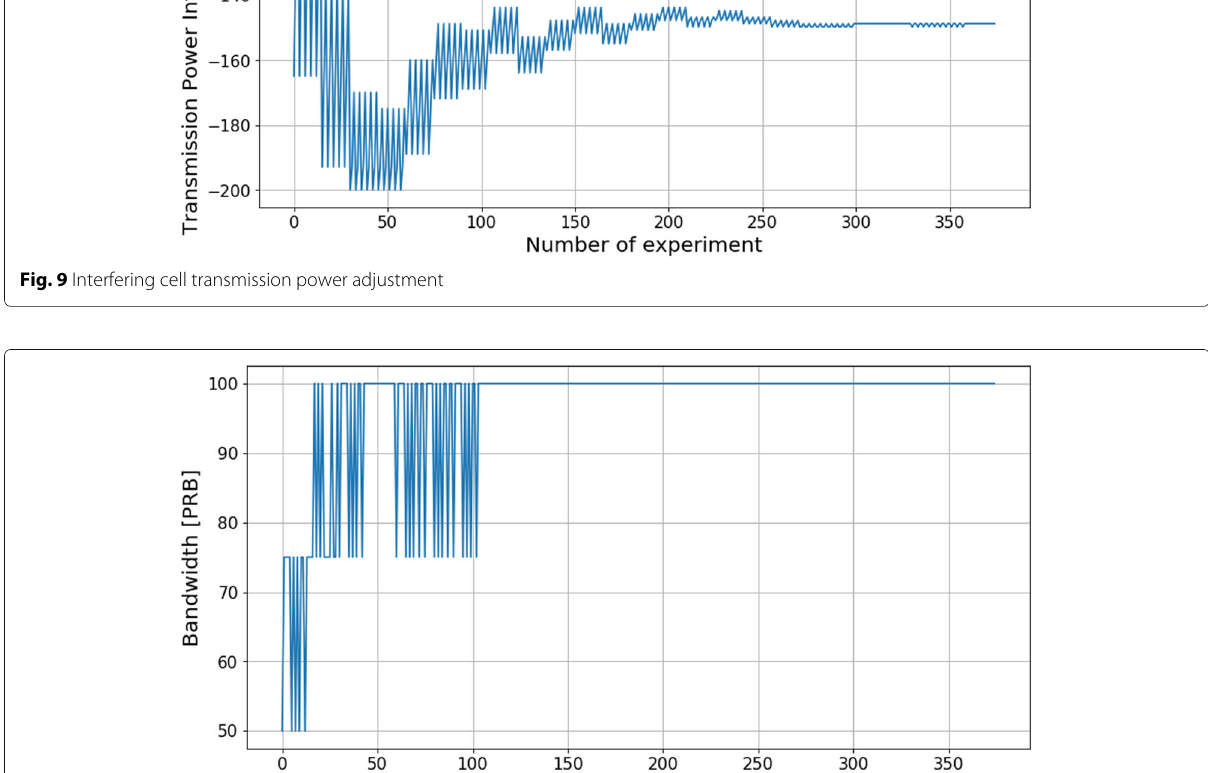
Fig. 10 Serving cell bandwidth